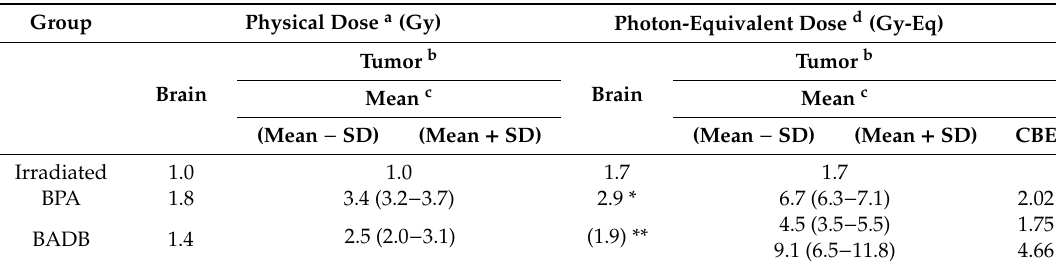
Table 2. The physical and photon-equivalent doses recorded during the neutron irradiation study. CBE: compound biological e ff ectiveness.